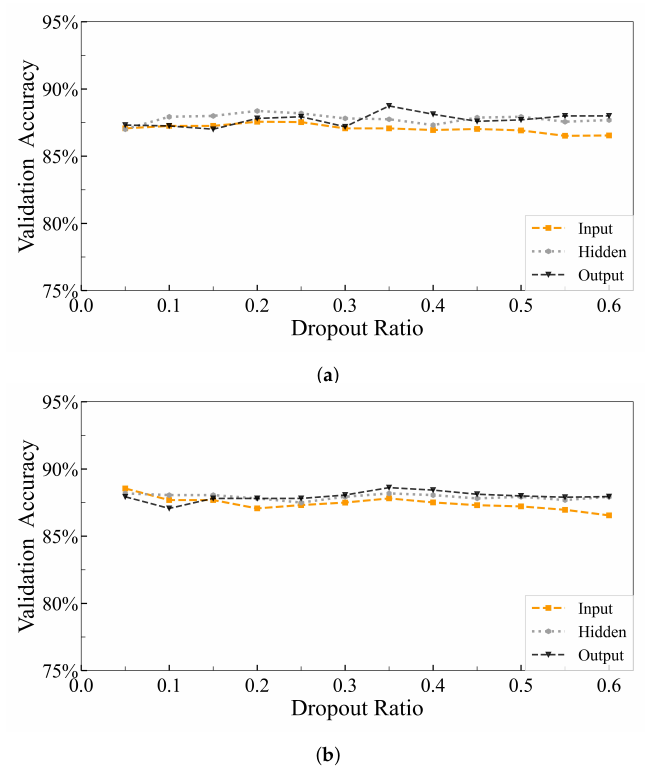
Figure 6. Influence of the dropout ratio on the M 0 model (validation set). ( a ) Network with 2 layers and 64 cells in each layer. ( b ) Network with 2 layers and 128 cells in each